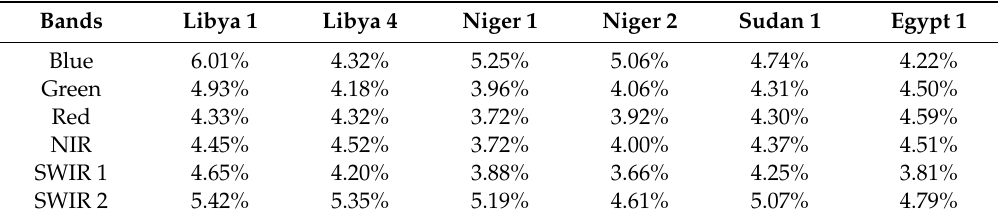
Table 15. Total average estimated uncertainty (%) for all six spectrally matched bands, by